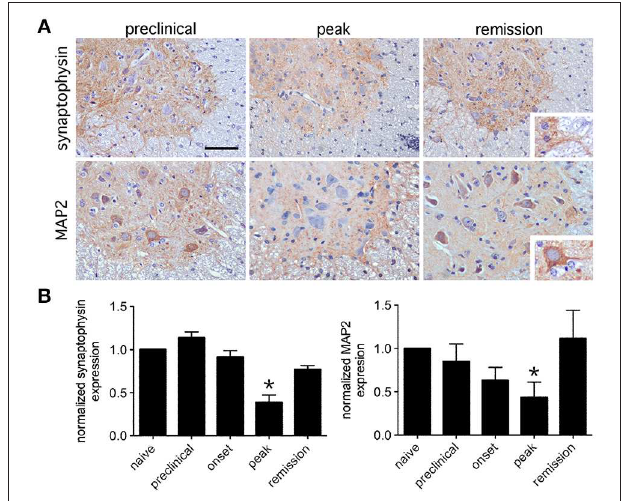
FIGURE 2 | Expression of synaptic proteins in lumbar spinal gray matter is dynamically regulated during relapsing EAE. (A) Representative immunohistochemical staining for the presynaptic protein, synaptophysin, and the postsynaptic protein, MAP2, shows that both proteins localize to lumbar spinal gray matter at varying stages of relapsing EAE in SJL mice. Inserts show that synaptophysin labels gray matter neuropil while MAP2 labels neuronal cell bodies and proximal dendrites. (B) Normalized expression of both proteins shows reduced levels at peak disease, but notable recovery by the time of disease remission only a few days later ( n = 5 samples per disease stage). Bar = 80 µ m, * p < 0.05 compared to preclinical